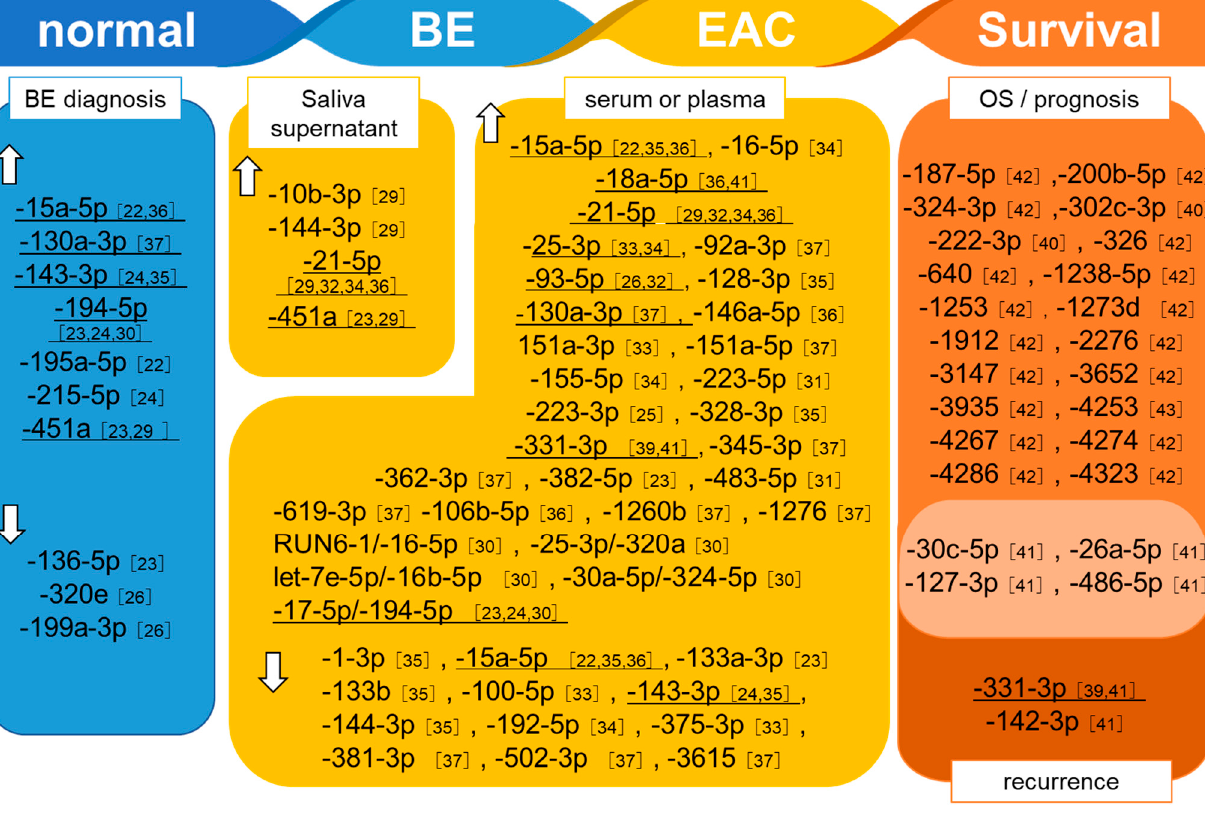
Figure 2. List of dysregulated miRNAs (identified in serum or saliva) that are specific for BE or EAC. Superscript numbers indicate references. Underlined miRNAs were reported in multiple reports. MiRNAs associated with both OS/prognosis and recurrence are shown as a Venn diagram.